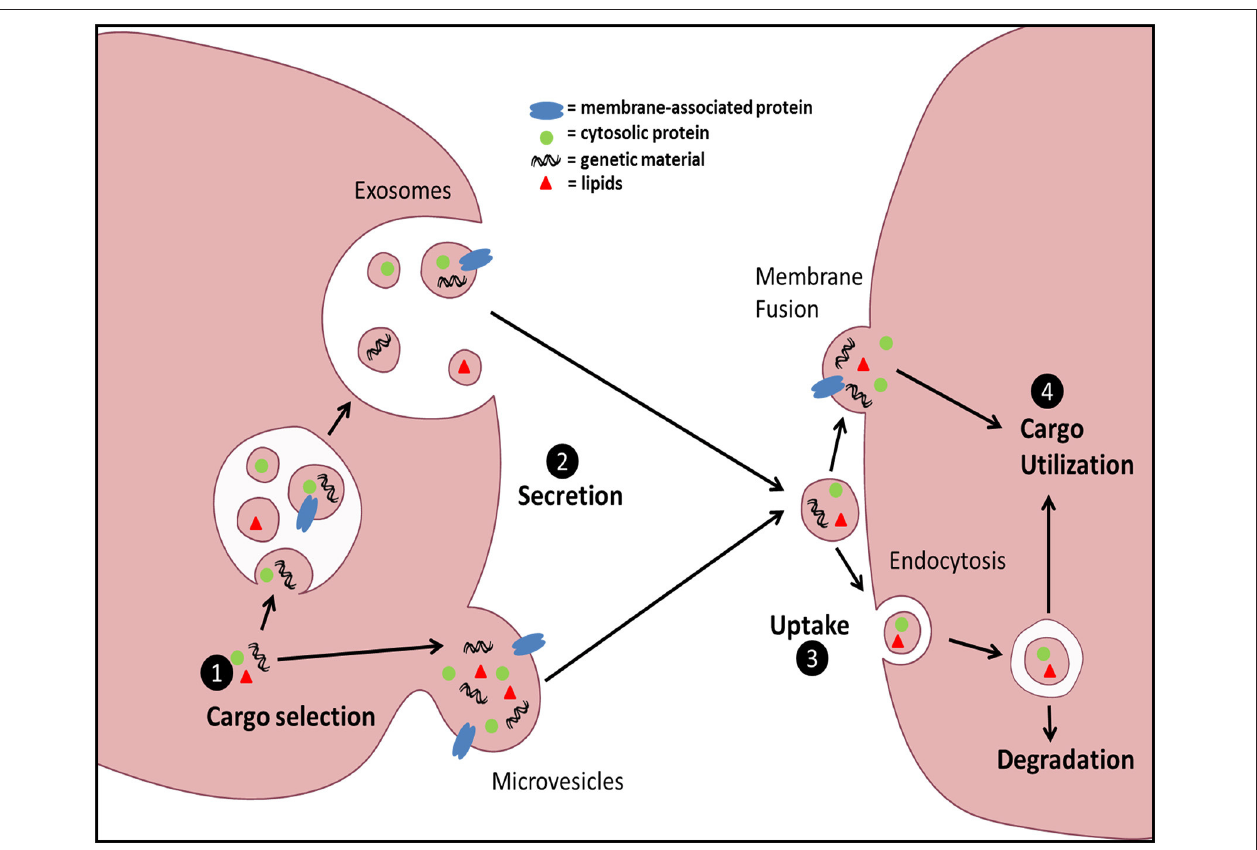
FIGURE 1 | General schematic of EV biogenesis and uptake. EV cargo can be sorted into two distinct EV populations: Exos or MVs. Exos are generated via inward budding of the multivesicular body (MVB) membrane and subsequently released via fusion of MVBs with the plasma membrane. MVs are generated by direct outward budding and fission of the plasma membrane. Uptake of EVs can be accomplished by either direct membrane fusion and release of EV contents into the target cell cytoplasm, or through various forms of endocytosis. Finally, the fate of the intravesicular cargo can be influenced by the form of uptake and the ability of the contents to avoid lysosomal